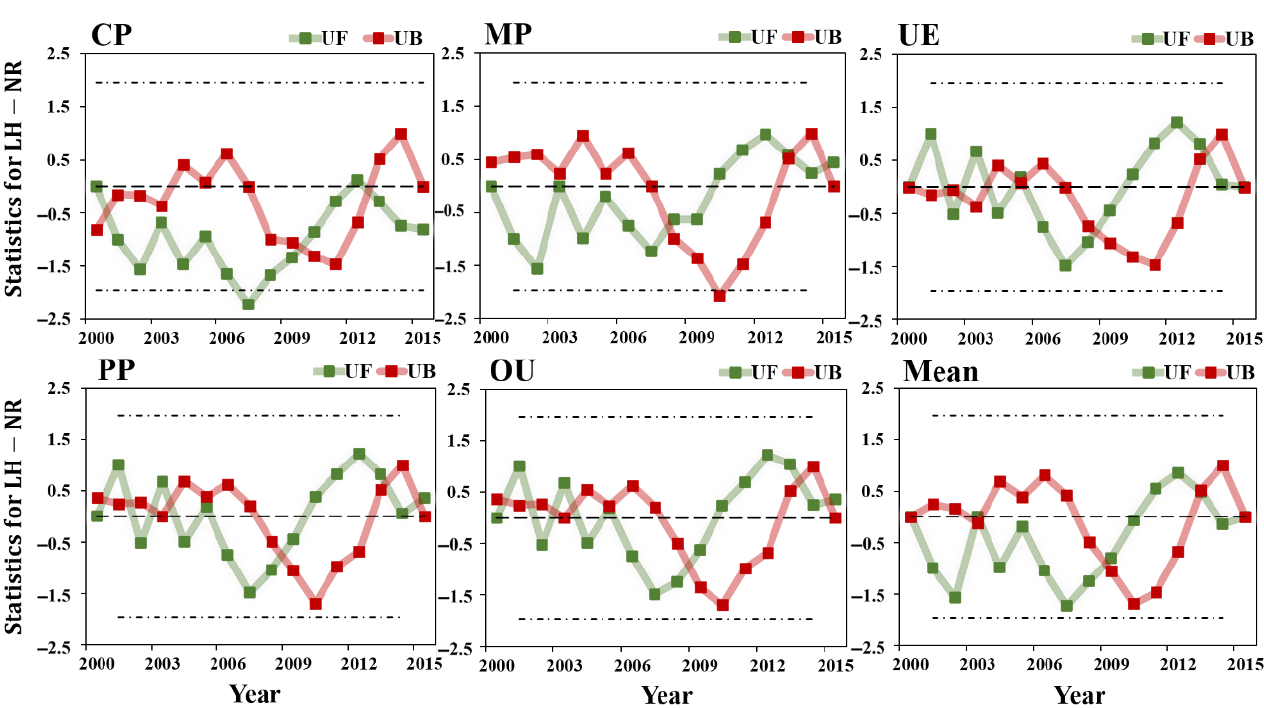
Figure 14. Mann – Kendall test of net radiation ( LH − NR ) for different land use types in the Huang- Huai-Hai River Basin from 2000 to 2015.